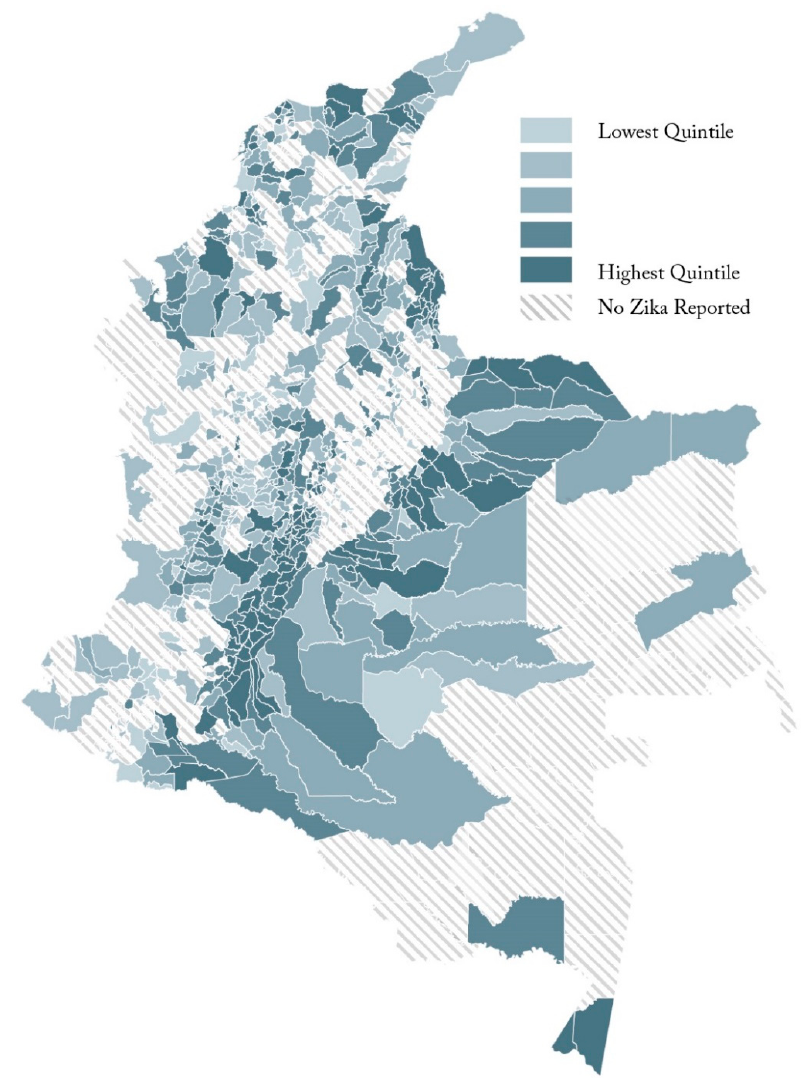
Figure 2. Municipality ‐ level Zika virus (ZIKV) occurrence per capita.